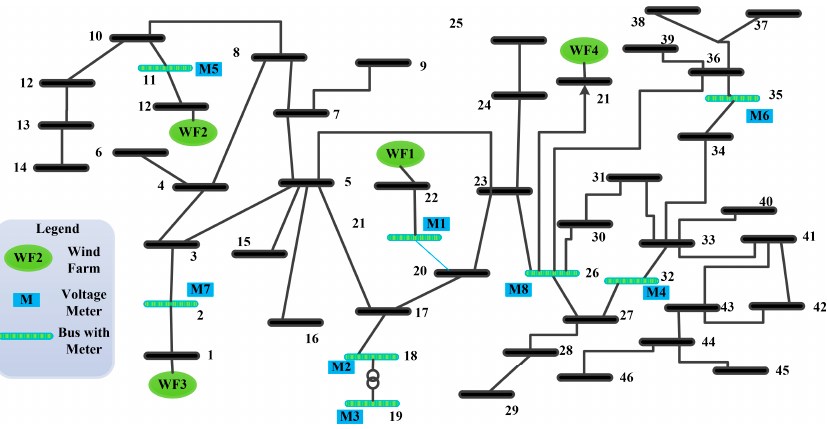
Figure 10. Simplified single line diagram of the Tasmanian transmission network. Table 7. Permissible harmonic current limits (pu) for harmonic sources in Tasmanian transmission network.